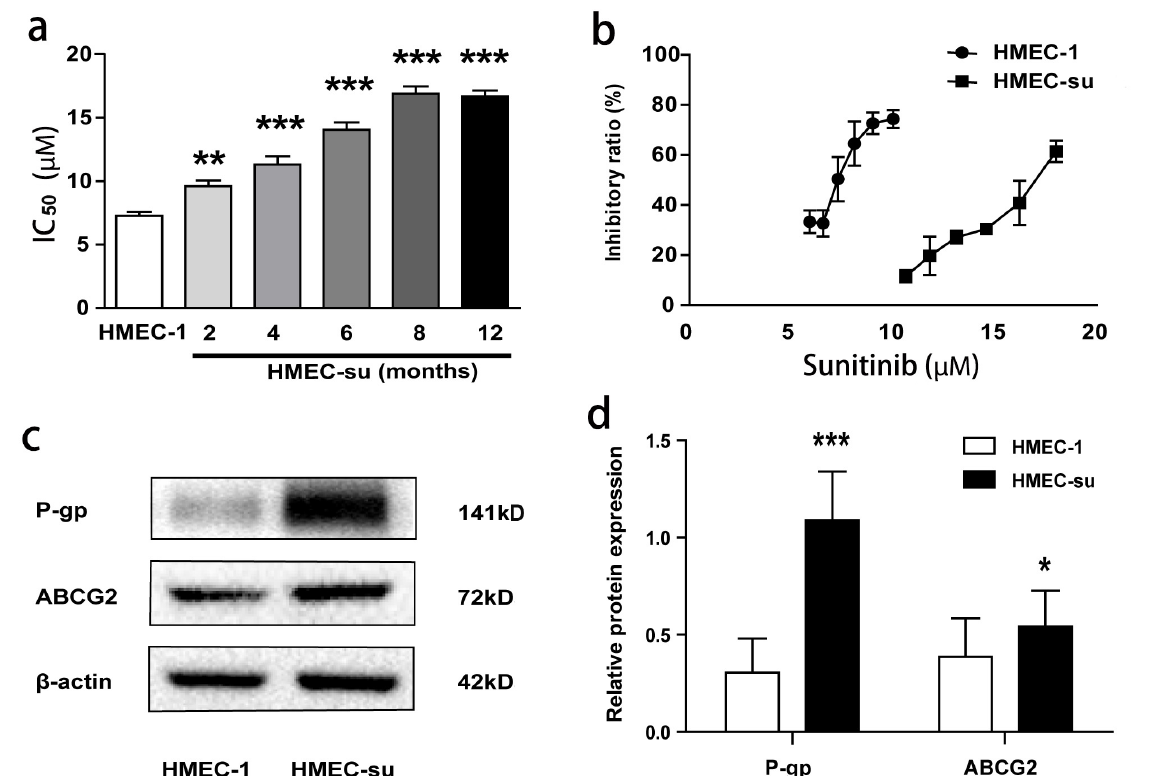
FIGURE 2 - Resistance to sunitinib and MDR protein expression in HMEC-1 cells and HMEC-su cells. (a) IC50 values of HMEC-su at different culture time. (b) Cell proliferation was determined by MTT assay, the inhibitory effects of sunitinib on HMEC-1 and HMEC-su was calculated after exposure to sunitinib at concentration of 5µM to 20 µM for 72 hours. The data shown are the means ± SD of triplicate determinations. **P < 0.01 was considered significant while ***P < 0.001 was highly significant, HMEC-su cells vs. HMEC-1 cells. (c) Elevated expression of P-gp and ABCG2 in HMEC-su cells in comparison with HMEC-1 cells. (d) Relative expression is shown, in which the intensity of bands for P-gp and ABCG2 was divided by corresponding β-actin band. All data were obtained from three independent western blot experiments. ** P < 0.01 and * P < 0.05 vs. HMEC-1